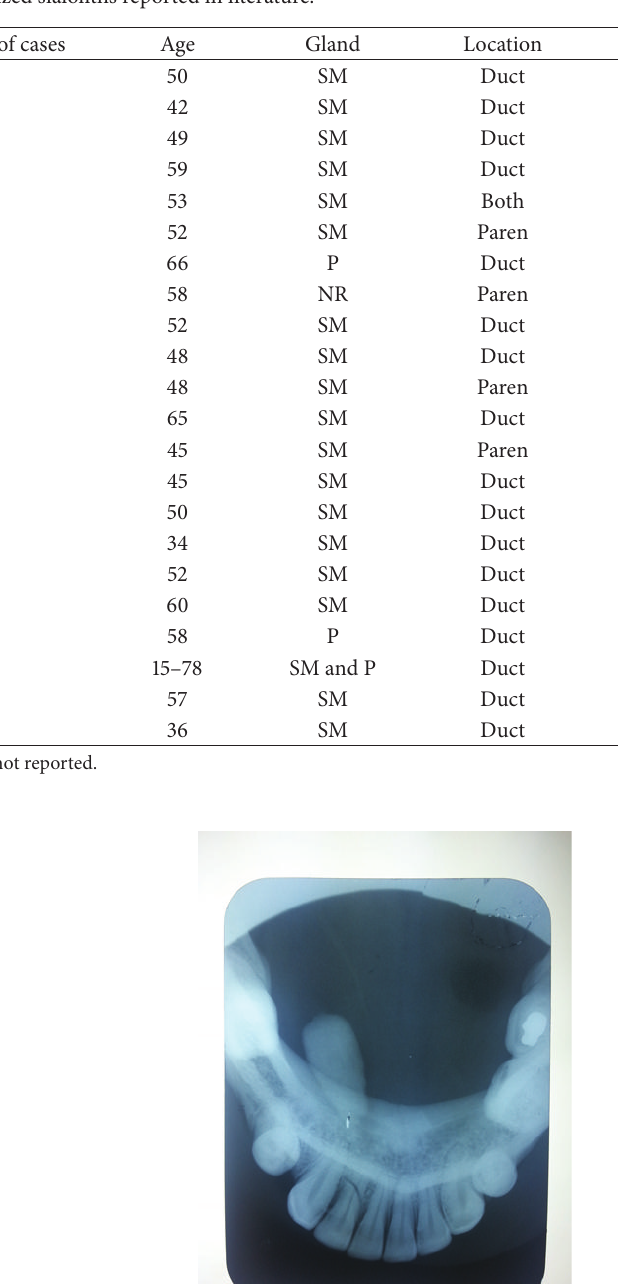
Table 1: Unusually sized sialoliths reported in literature.